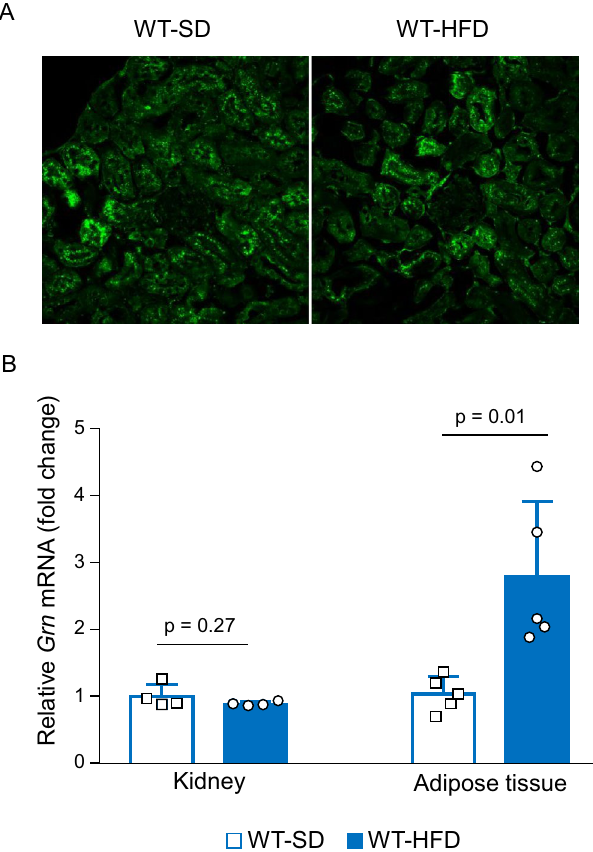
Figure 2. Grn mRNA and protein expression levels in the kidney and adipose tissue of the WT-SD and WT-HFD groups. ( A ) Immunofluorescence staining for PGRN shows PGRN expression primarily localized to the tubules. ( B ) Grn mRNA expression levels in the kidney and adipose tissue by real-time PCR. There is no difference in the renal Grn mRNA expression level between the WT-SD and WT-HFD groups. Conversely, the adipose tissue Grn mRNA expression level is significantly higher in the WT-HFD group than in the WT-SD group. Student’s unpaired t